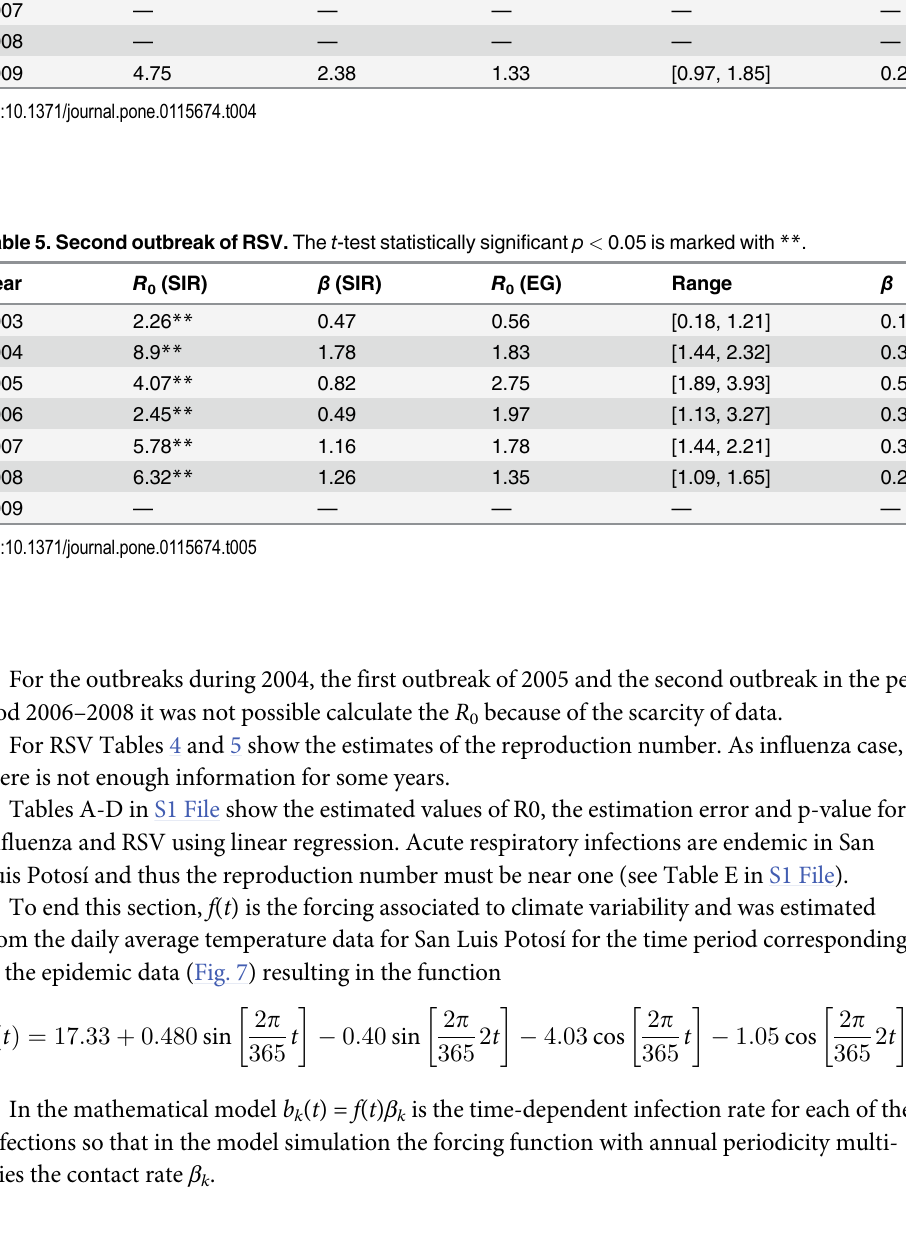
Table 4. First outbreak of RSV. The t -test statistically significant p < 0.05 is marked with ** . Year R 0 (SIR) β (SIR) R 0 (EG) Range β 2003 — — — — — 2004 — — — — — 2006 — — — — — 2007 — — — — — 2008 — — — — —